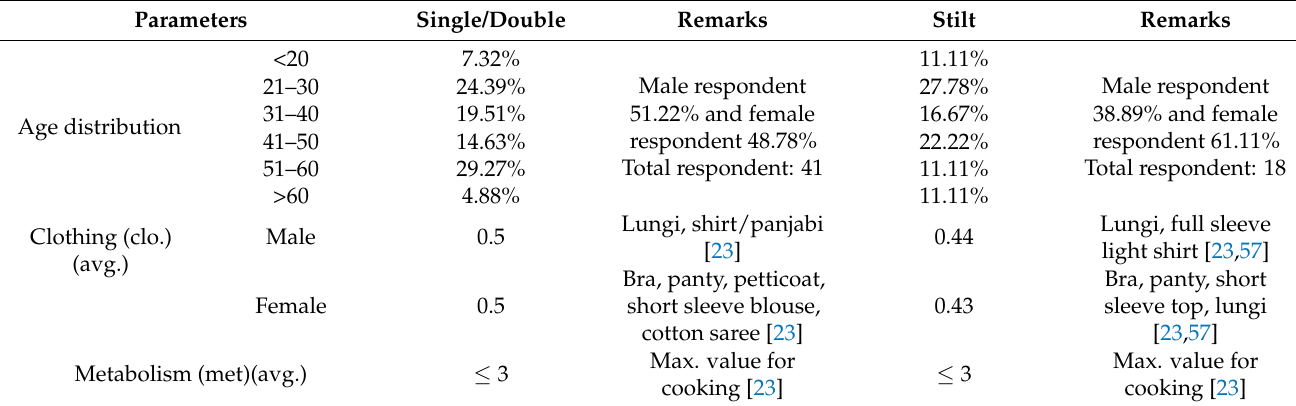
Table 7. Personal parameters of the